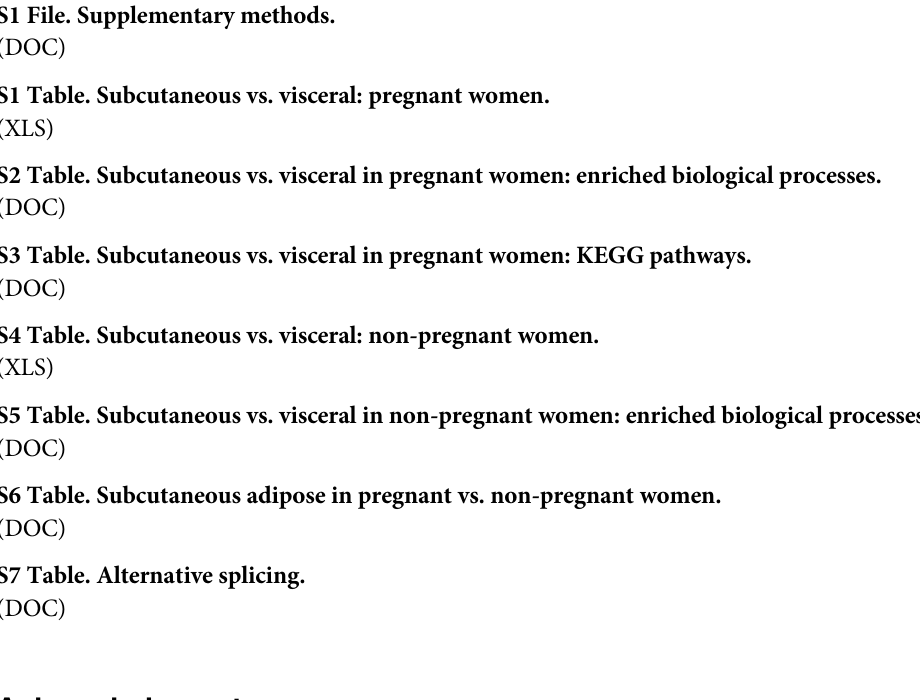
S3 Fig. Rendering of the Protein digestion and absorption KEGG pathway (hsa04974) showing genes and genes complexes as colored rectangles (blue = down-regulation, magenta = up-regulation) between subcutaneous and visceral tissues of pregnant women. The genes COL12A1, COL15A1, COL3A1, COL4A1, COL4A2 and COL5A2 are shown as a single rectangle (Collagen). The same is true about ACE2, DPP4, MME and XPNPEP2, which are represented as the Peptidase rectangle. (TIF) S4 Fig. Rendering of the Complement and coagulation cascades KEGG pathway (hsa04610) showing genes and genes complexes as colored rectangles (blue = down-regulation, magenta = up-regulation) between subcutaneous tissues of pregnant and non-pregnant women. The genes C1QA, C1QB and C1QC are shown as a single rectangle (C1Q). (TIF) S5 Fig. Rendering of the Prion diseases KEGG pathway (hsa05020) showing genes and genes complexes as colored rectangles (blue = down-regulation, magenta = up-regulation) between subcutaneous tissues of pregnant and non-pregnant women. The genes C1QA, C1QB and C1QC are shown as a single rectangle (C1q). (TIF) S6 Fig. Normalized probe expression data against the genomic coordinates for gene GSTK1. (TIF) S1 File. Supplementary methods. S1 Table. Subcutaneous vs. visceral: pregnant women. (XLS) S2 Table. Subcutaneous vs. visceral in pregnant women: enriched biological processes. (DOC) S3 Table. Subcutaneous vs. visceral in pregnant women: KEGG pathways. (DOC) S4 Table. Subcutaneous vs. visceral: non-pregnant women. (XLS) S5 Table. Subcutaneous vs. visceral in non-pregnant women: enriched biological processes. (DOC) S6 Table. Subcutaneous adipose in pregnant vs. non-pregnant women. (DOC) S7 Table. Alternative splicing.